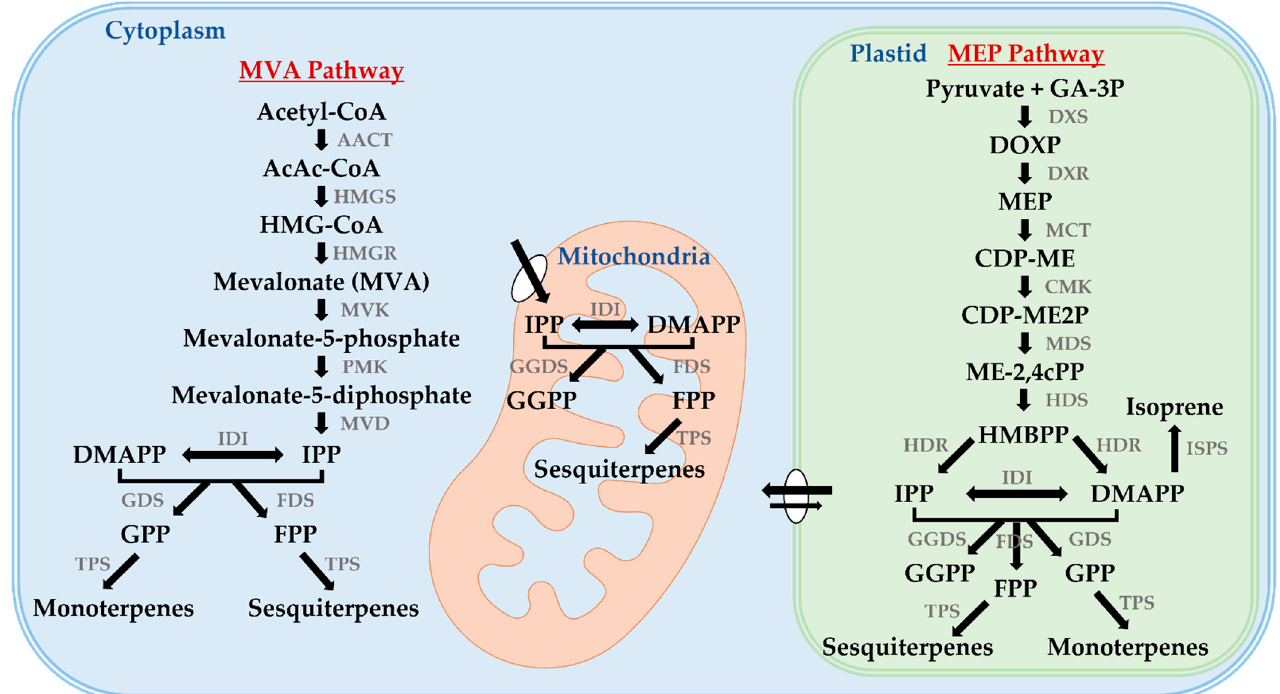
Figure 1. Biosynthetic pathways of volatile terpenes in plants (adopted and modified from Nagegowda [50]). AACT = acetoacetyl-CoA thiolase; AcAc-CoA = acetoacetyl-CoA; CDP-ME = 4-(cytidine